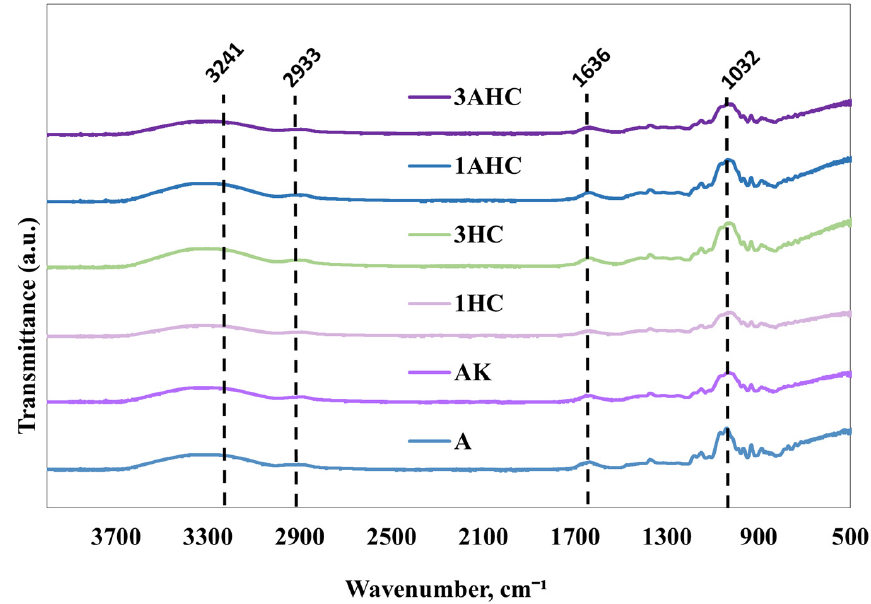
Figure 6. FTIR results of agar, agar/KGM, and CHAK.